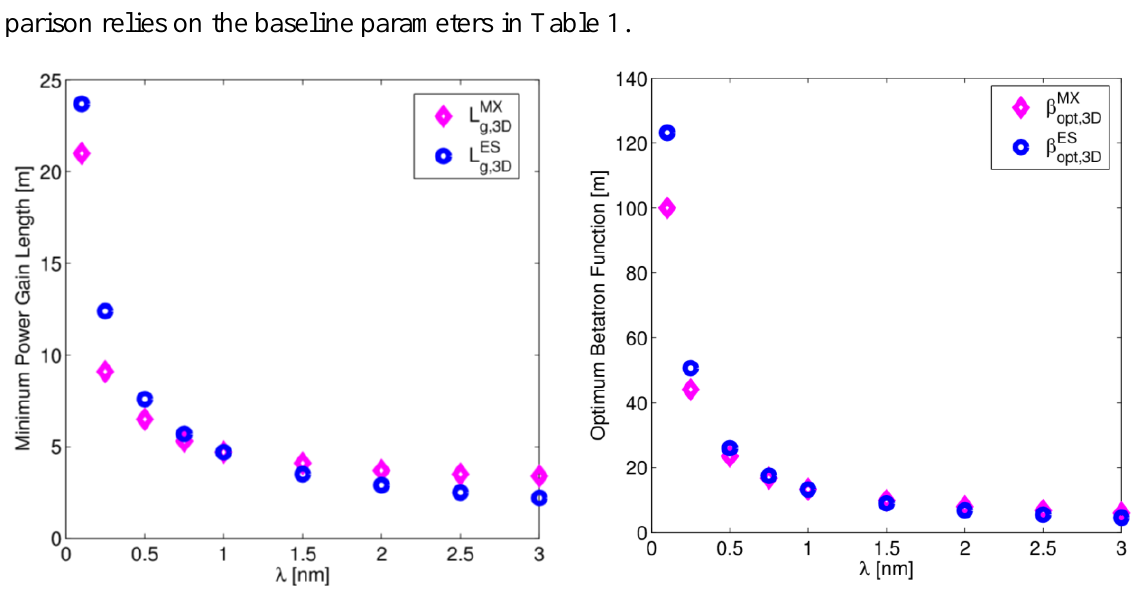
Figure 2. Minimum 3-D power gain length ( left ) and optimum betatron function ( right ) as function of the FEL fundamental wavelength, for the M. Xie (circles) and E. Saldin et al. (dots)